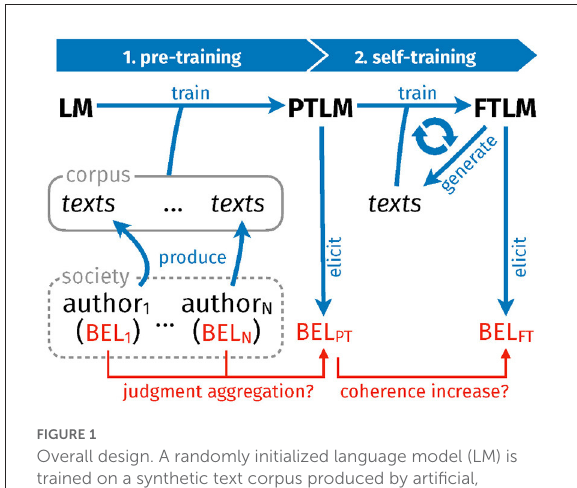
FIGURE1 Overall design. A randomly initialized language model (LM) is trained on a synthetic text corpus produced by artificial, simulated authors. The accordingly pre-trained model (PTLM) subsequently trains on self-generated texts, which finally yields a fine-tuned model